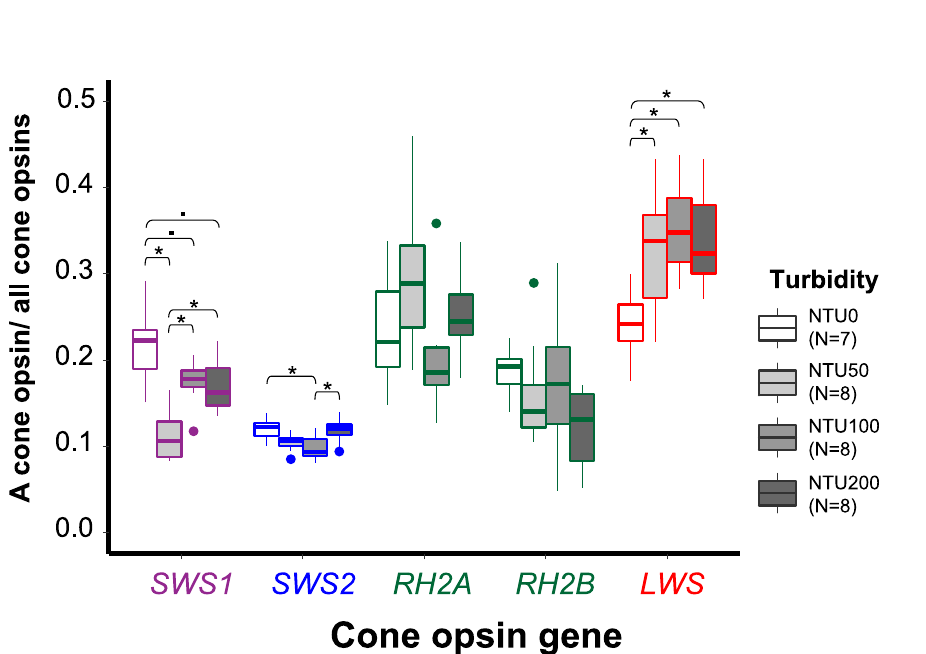
Fig 5. Box plot showing the median (—), 25 th and 75 th percentiles (box), 95% range (|), and outliers (•) of cone opsin proportional expression values for different turbidity treatments. An asterisk indicates P < 0.05 (one-way ANOVA, post hoc Tukey’s comparisons) and a dot indicates 0.10 > P > 0.05 (one-way ANOVA, post hoc Tukey’s comparisons). The color of the boxes of each opsin family represents its general λ max range. SWS1 ’s is ultraviolet light, SWS2 ’s is blue light, RH2 ’s is green light, and LWS ’s is red light.